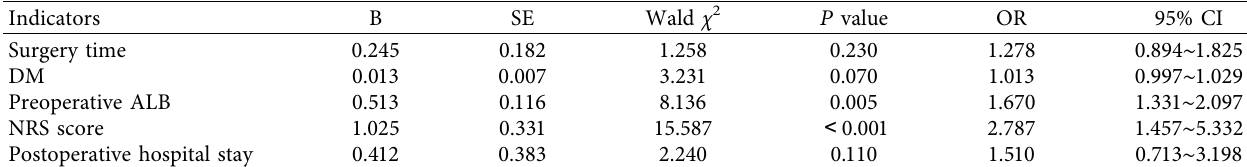
Table 5: Analysis of risk factors for postoperative complications in